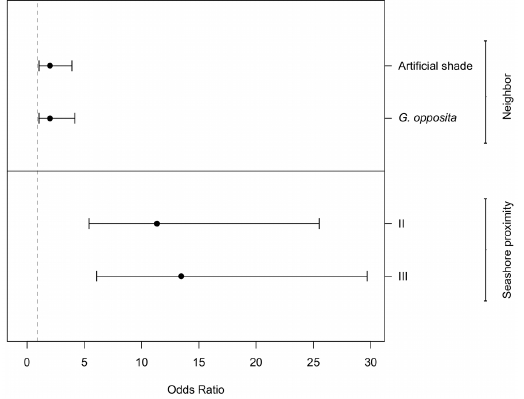
Figure 2. Odds ratios (95% confidence intervals) of seedling survival of Ternstroemiabrasiliensis after 358 days. The odds of seedling survival beneath Guapira opposita , artificial shade and seashore proximity II and III was compared to seedling survival in the reference condition (control with no neighbor in the seashore proximity I, the closest proximity to the seashore). An odds ratio of 1 indicated no difference between odds of seedling survival in the treatment and in the reference; . 1 indicated a greater survival odds in the treatment than in the reference. The estimates are based in the selected model (model M2.S in Table